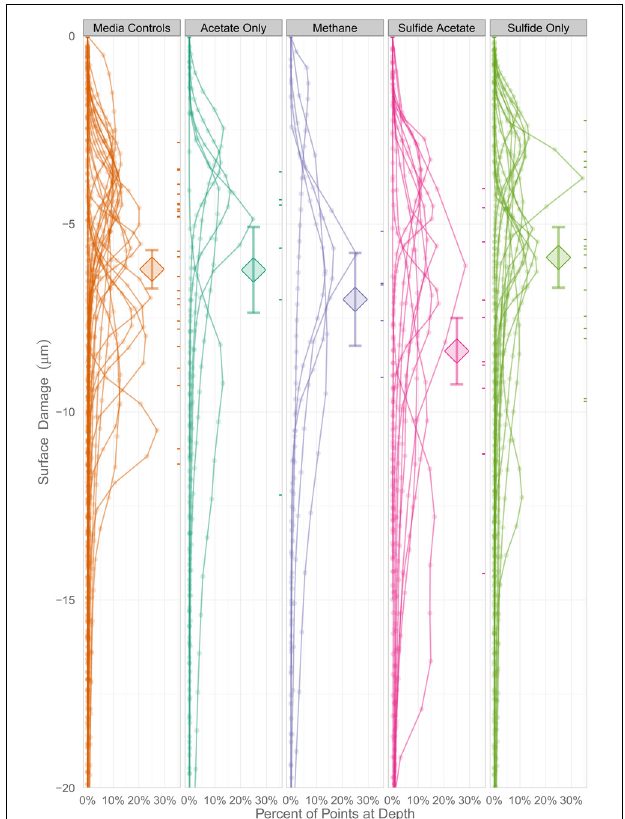
FIGURE 7 | A Bayesian multilevel model comparing the mean surface damage for treatment groups as well as individual coupons. The diamonds indicate a treatment group’s mean depth, and the tick marks on the right side of the columns indicate an individual coupon’s mean depth. The error bars mark the 16 and 84% percentiles of each treatment’s posterior distribution, which corresponds to the asymptotic 68% coverage of a ± 1 standard error band, but is allowed to be